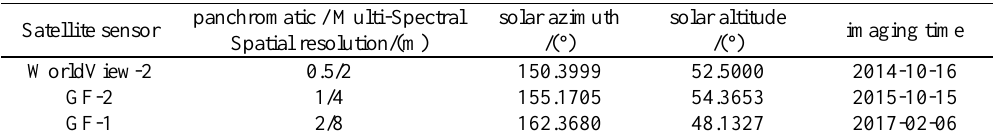
Table 1. Basic parameters of data source